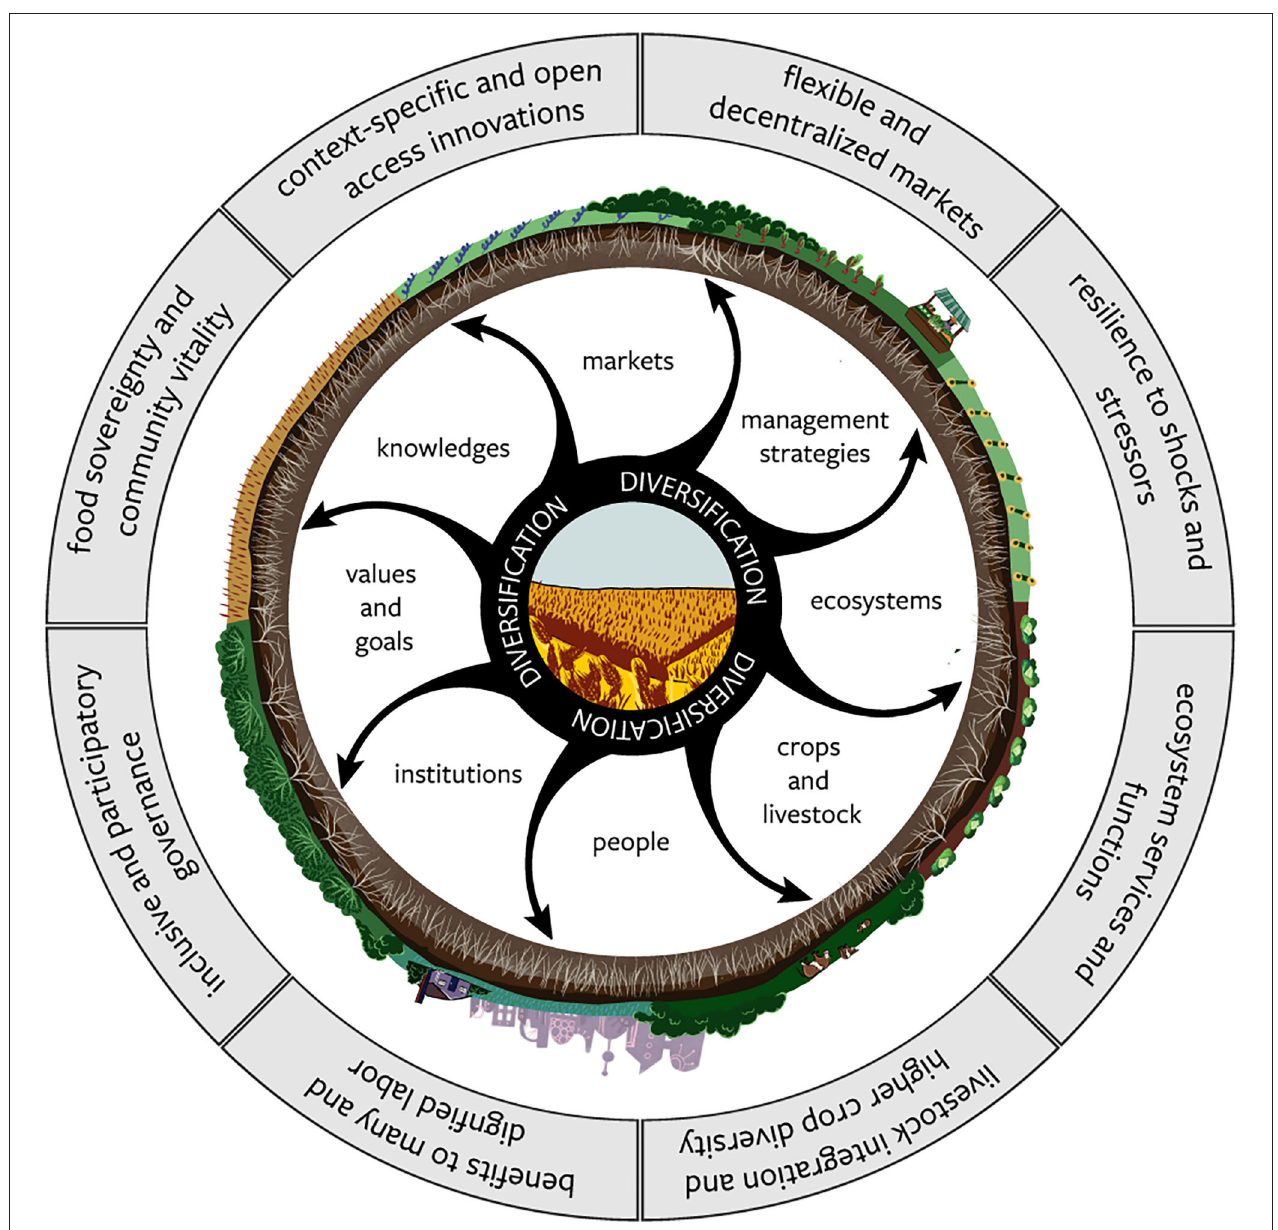
FIGURE 3 | As farming systems move from a simplified state (center of wheel) to a more diversified state (outer ring of wheel) along multiple dimensions (spokes of the wheel) adaptive capacity can emerge. But the wheel will only “turn well” when multiple dimensions grow together and interact, i.e., progress along only one or two dimensions will not be sufficient to create these